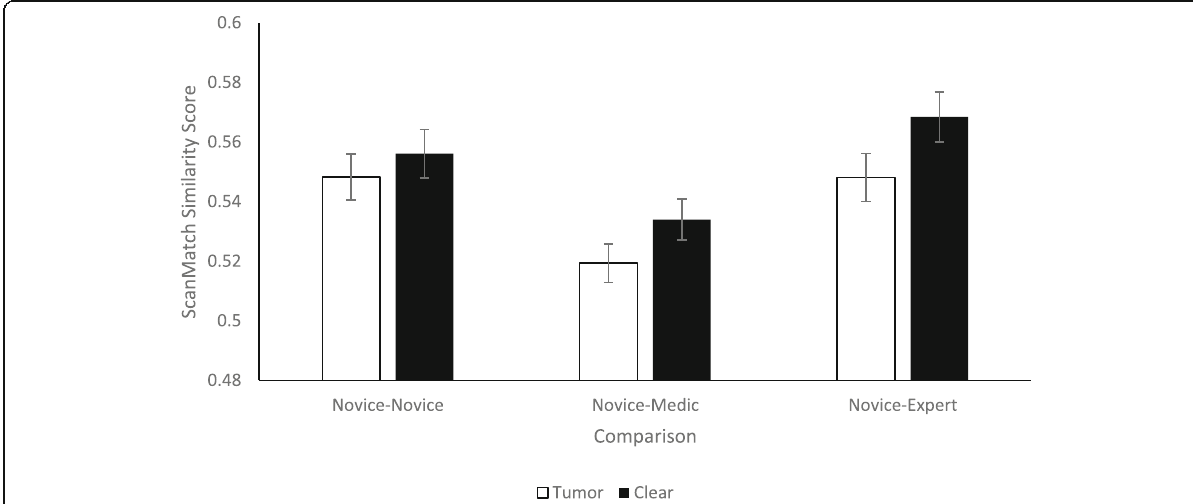
Fig. 5 Interaction between between-group comparison and diagnosis on ScanMatch similarity score when Novices are the reference group. Error bars represent standard error